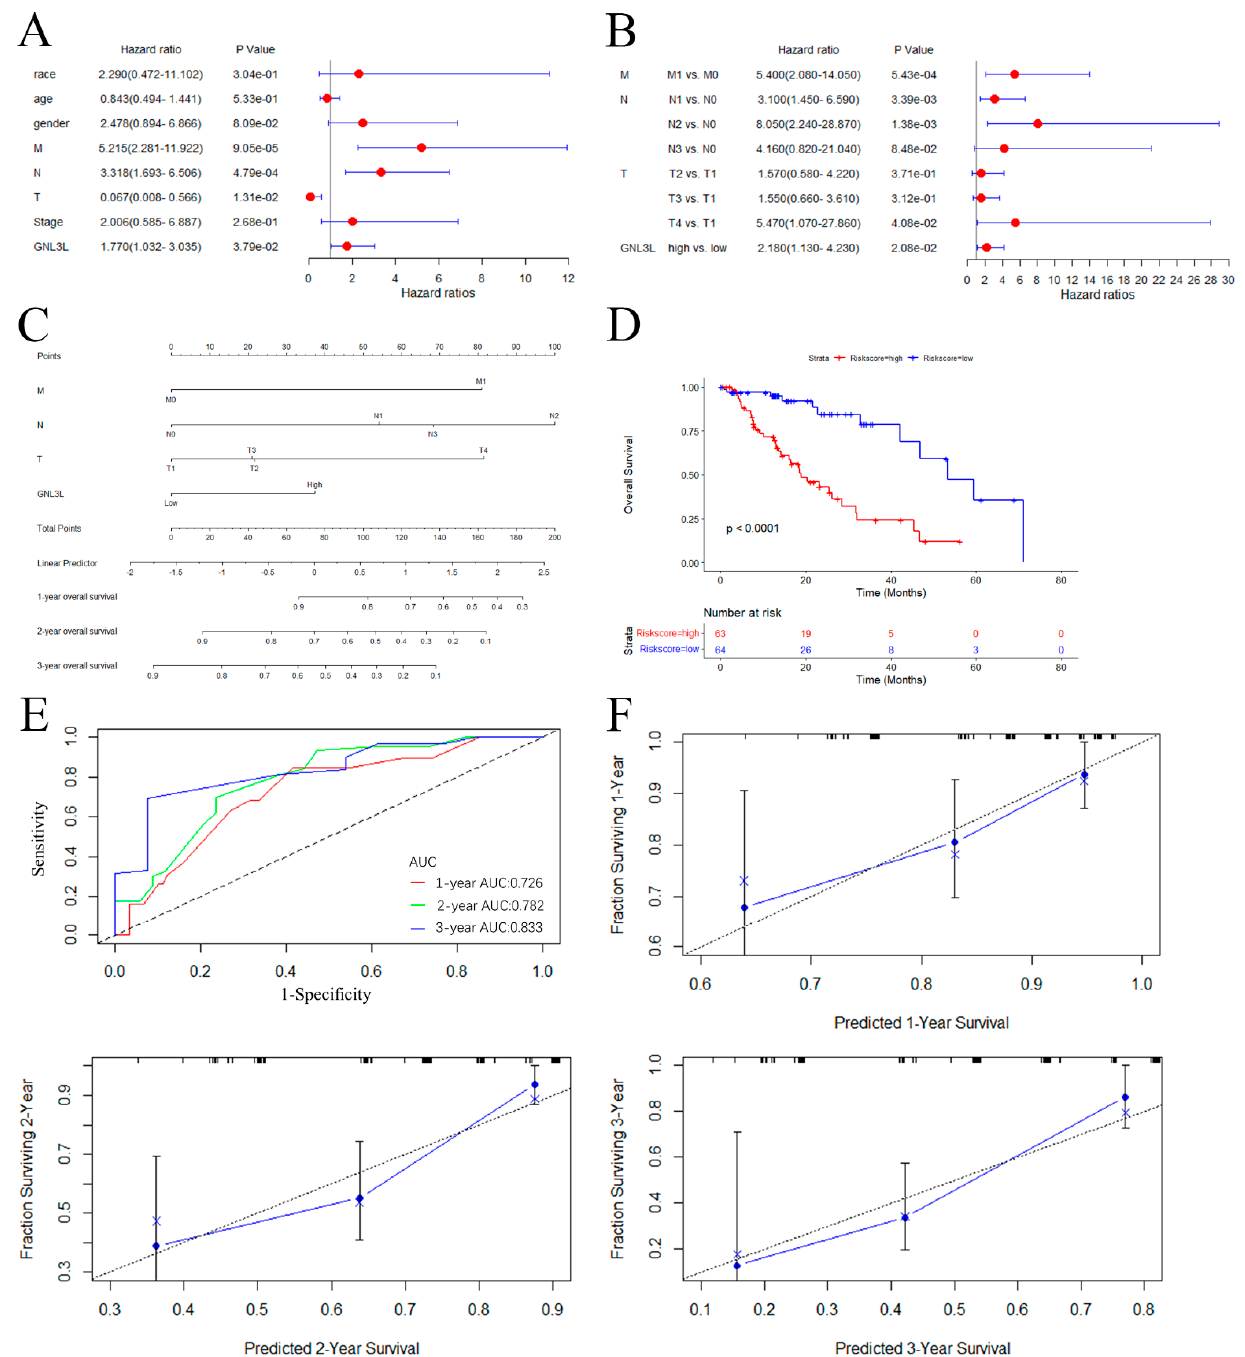
Figure 11. ESCA prediction model building and evaluation. ( A ) Forest plot of univariate Cox regression results. ( B ) Forest plot of multi-factor Cox regression results. ( C ) The nomogram based on GNL3L and M, T, and N stages. ( D ) Kaplan–Meier curves plotted after stratifying high − risk and low − risk patients based on median risk scores derived from the nomogram. ( E ) Evaluation of the ROC curve of the nomogram. ( F ) Evaluation of the calibration curve for the nomogram.